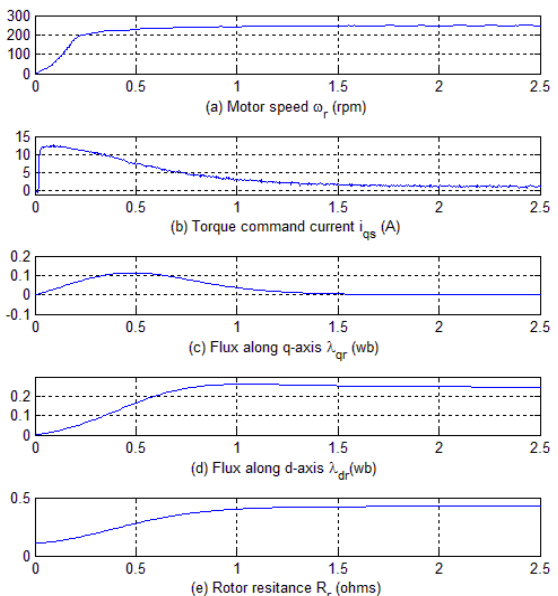
Figure 17. Experimental results with R r /4 and adaptation. ( a ) Motor speed in rpm; ( b ) Torque command current in synchronous frame of reference; ( c ) Flux along q-axis in synchronous frame of reference; ( d ) Flux along d-axis in synchronous frame of reference; ( e ) Rotor